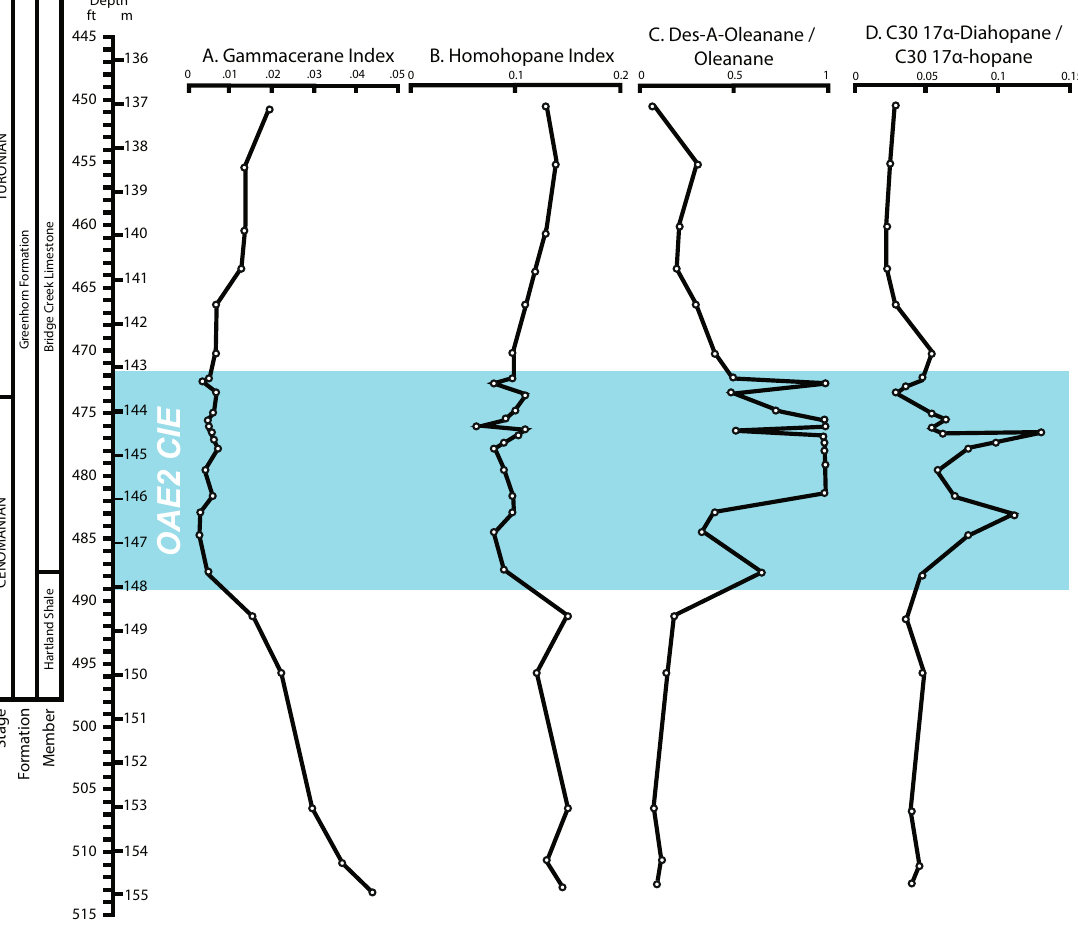
Figure 3. Compound tracks through OAE2 relating to oxygenation before, during, and after the event. Gammacerane and Homohopane Indexes, which are affected by sediment redox conditions, show a significant decrease and the ratios related to 17α-Diahopane exhibit an increase with striking fluctuations within OAE2. These broad scale changes reflect an overall increase in oxygenation during OAE2, with periods of reducing conditions punctuated through the event. The relative preservation of des-A-oleanane revealed by the des-A- oleanane/oleanane ratio could be a function of